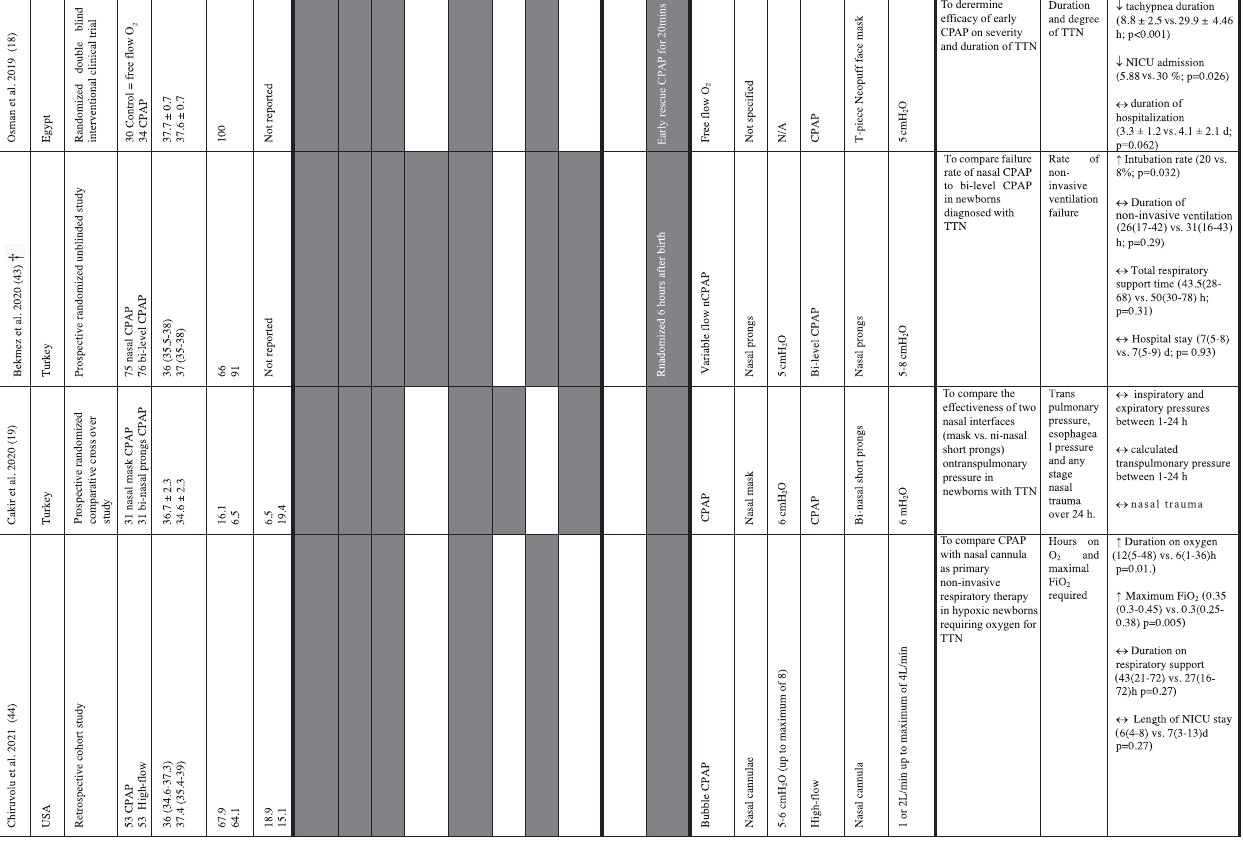
Summary of study demographics, TTN diagnostic characteristics, variables in delivery of intervention and study outcome between standard management and intervention. Studies are listed in chronological order to provide insights into approaches over time. Characteristics reported as per individual studies are presented in table as text or grey shaded squares. Data were expressed as mean ± SD unless otherwise indicated as # mean ± SEM; † median (interquartile range). CPAP, continuous positive airway pressure; HFPV, high-frequency percussive ventilation; NIMV, nasal intermittent mandatory